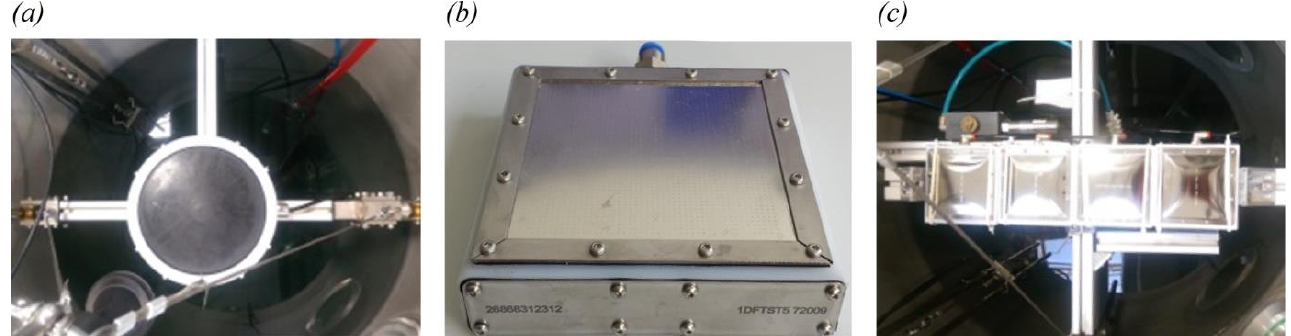
Figure 2. Installation of membrane disc diffuser in the DN 900 column ( a ). Photograph of a micro-perforated plate diffuser ( b ). Arrangement of plate diffusers in the DN 900 column ( c ).